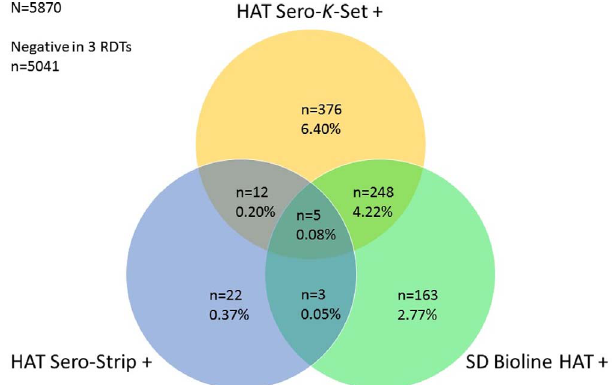
Figure 5. Venn diagram presenting the results of the 829 study participants who tested positive to at least one of the three rapid diagnostic tests for